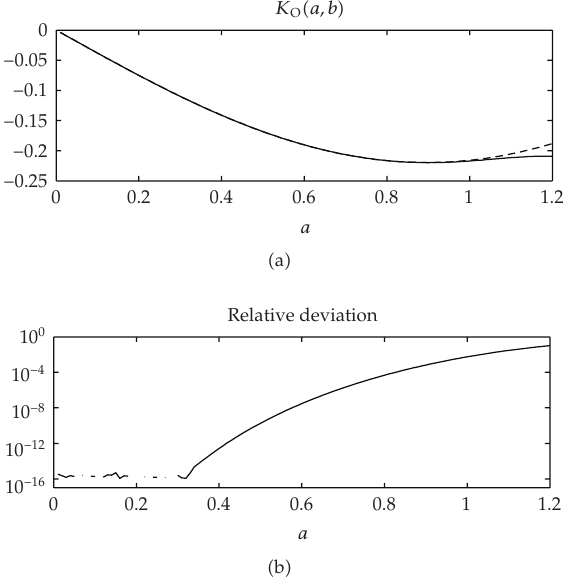
Figure 12: Comparison of the direct series evaluation (cid:2) solid (cid:3) and the analytic representation (cid:2) dashed (cid:3) for the odd-order spectra K O with n (cid:6) 0, b (cid:6) 0 . 95 as a is varied. The inset shows the relative di ff erence between the direct series evaluation and the analytic